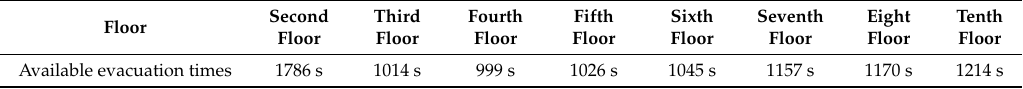
Table 7. The dangerous time caused by smoke temperature in different